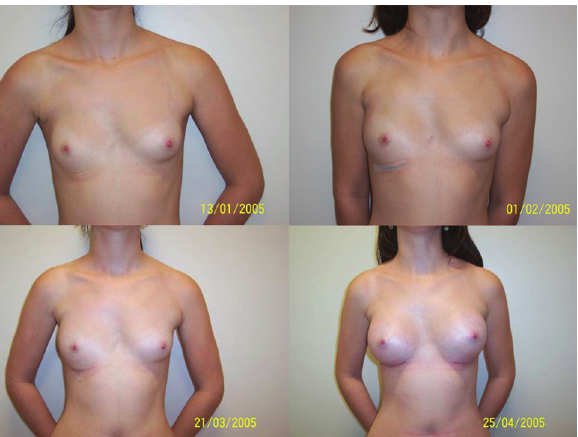
Figure 6 - A patient with Poland’s syndrome on the right side. Nineteen days after the omentum flap transposition, it is possible to see the beginning of the omentum’s growth in the lateral portion of the breast. Two months after omentum flap transposition only, the right breast had doubled in size, becoming bigger than the left breast. In the last picture, the right side has received a 200 cc high-profile implant while the left side has received a 225 cc low-profile